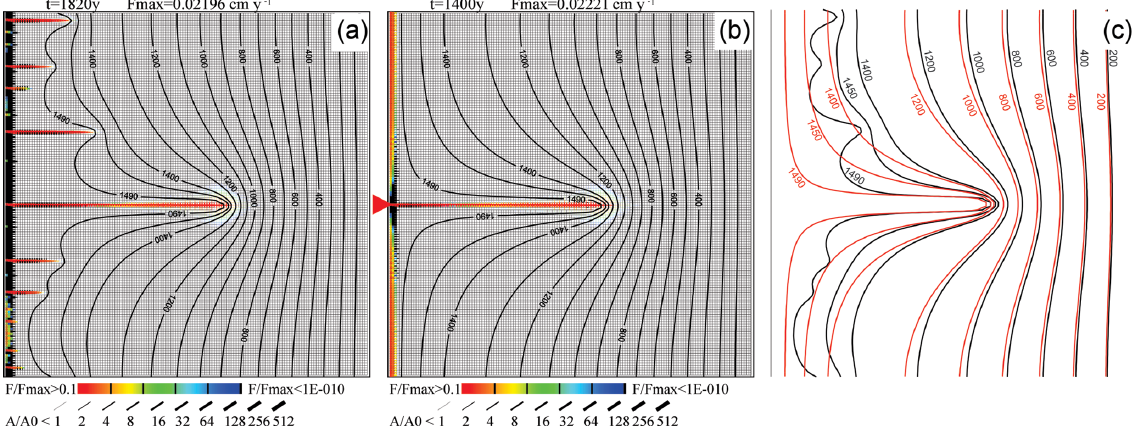
Figure 6. Comparison between the case with no seeds ( a , see Fig. 3) and single-seeded case ( b , see Fig. 5) at equal length of the dominant wormholes. (c) Overlaid head distribution from a case with no seeds ( a , black) and a seeded case ( b ,